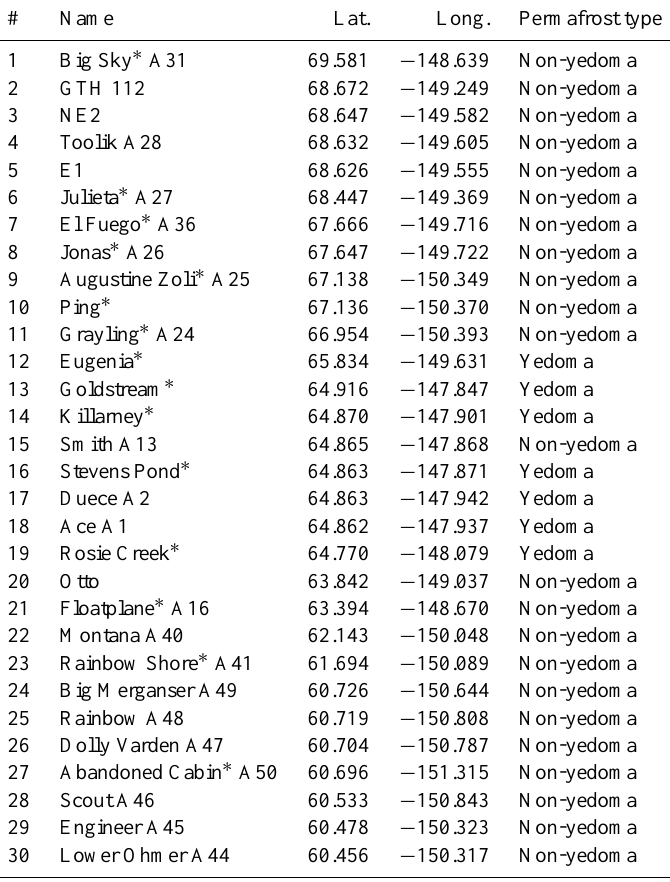
Table 1. Identification, location, and permafrost soil type for lakes included in the study. # Name Lat.